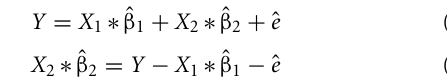
blue lines) fitted the data (red line) the same way giving the same R 2 . In addition, since the model degrees of freedom depend on the rank of the design matrix, all models have the same degrees of freedom giving the same F - and p- values. Differences arise when considering effect sizes (beta values) and t -values for the parameter of interest against 0, defined by the contrast